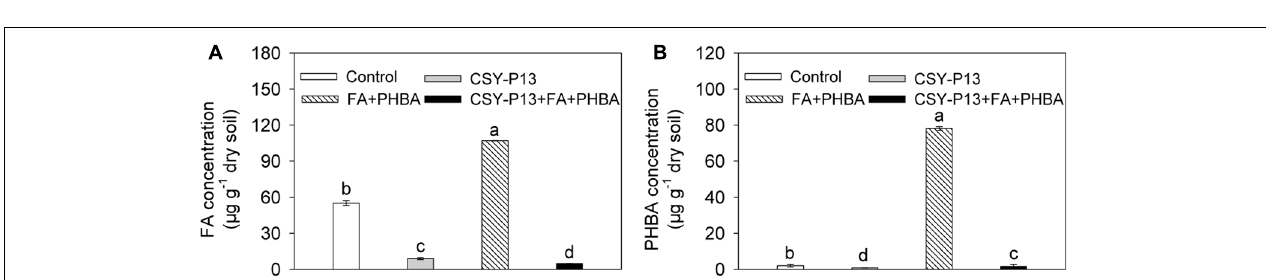
FIGURE 3 | FA (A) and PHBA (B) degradation by CSY-P13 in cucumber-planted soil. Control, supplemented with water; FA+PHBA, supplemented with the mixture of FA and PHBA; CSY-P13, supplemented with CSY-P13; CSY-P13+FA+PHBA, supplemented with CSY-P13 and the mixture of FA and PHBA. Bars represent standard errors of three biological replicates. Values with the different letters are significantly different at P < 0.05 by LSD test using SPSS for Windows 22.0 software (IBM Corp., Armonk, NY, United States).